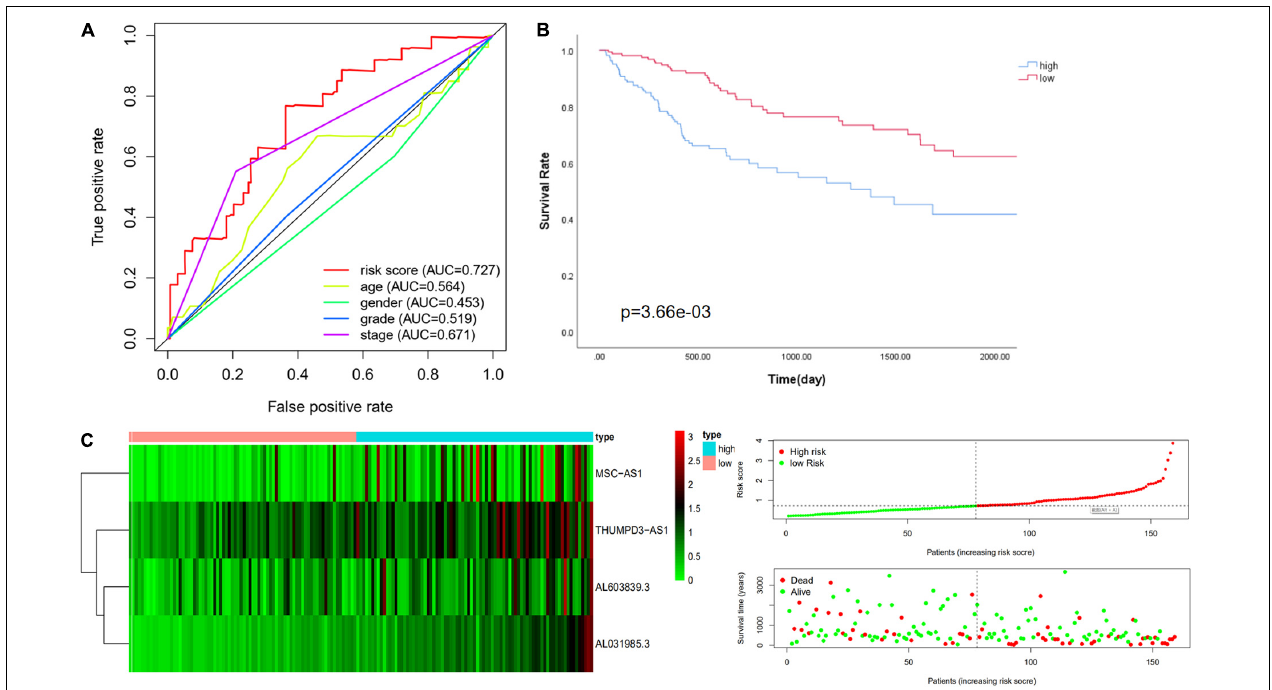
FIGURE 2 | Performance evaluation of the four immune LncRNA for survival prediction in the validation cohort. (A) ROC curve for 5 years of OS. (B) Kaplan–Meier survival curve for high-risk and low-risk groups divided by the median. (C) Heatmaps, distribution of risk scores with survival, and statuses of patients depend on selected immune LncRNA expression.